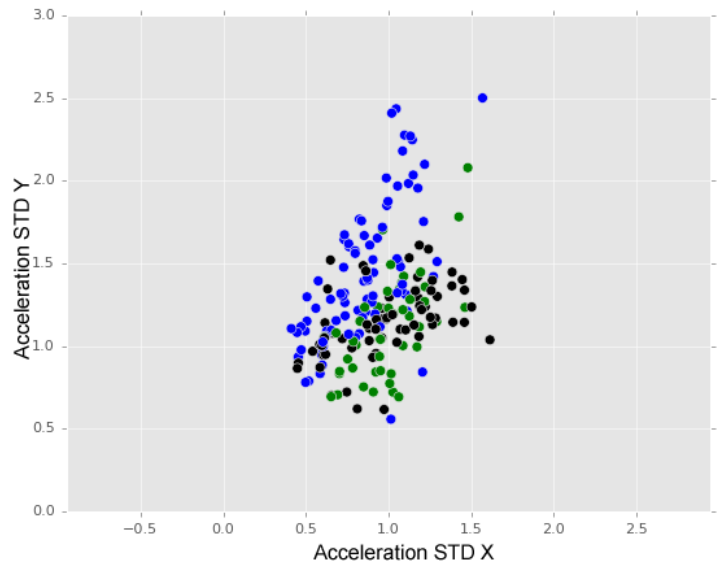
Figure 13. Bumps (blue dots), manholes (green dots), and others (black dots).